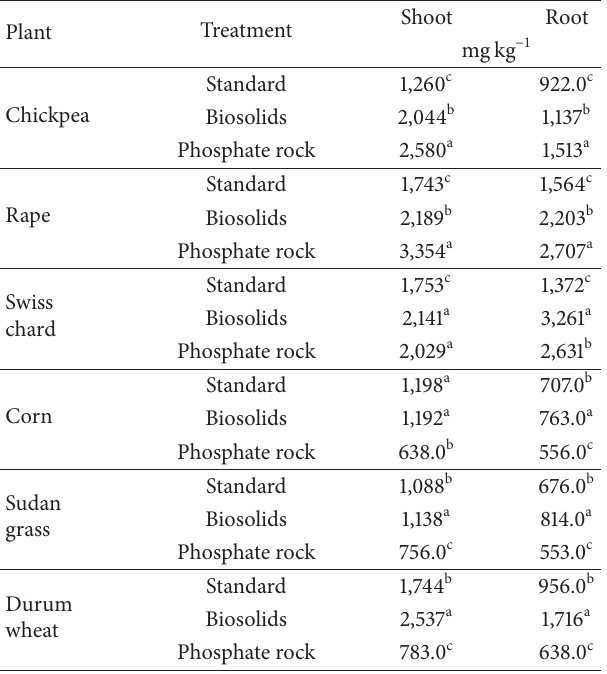
Table 6: P concentration of six plant species grown on sand media amended, without biosolids (Standard), with biosolids, and with phosphate rock †